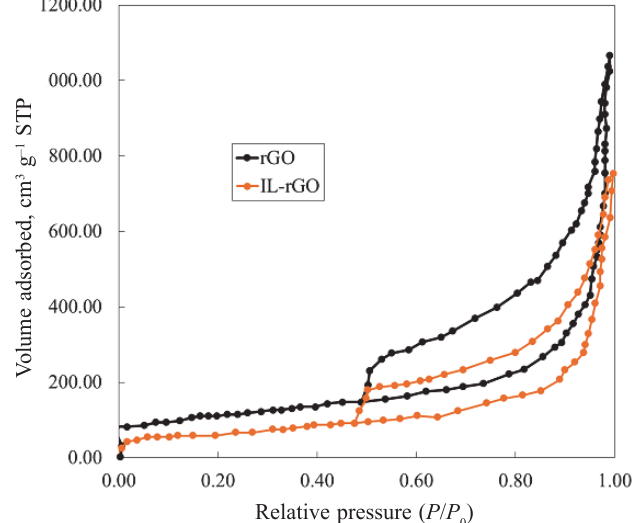
Fig. 1 – N sorption isotherms of graphene oxide, reduced 2 graphene oxide, and ionic liquid modified reduced graphene oxide samples measured at 77 K